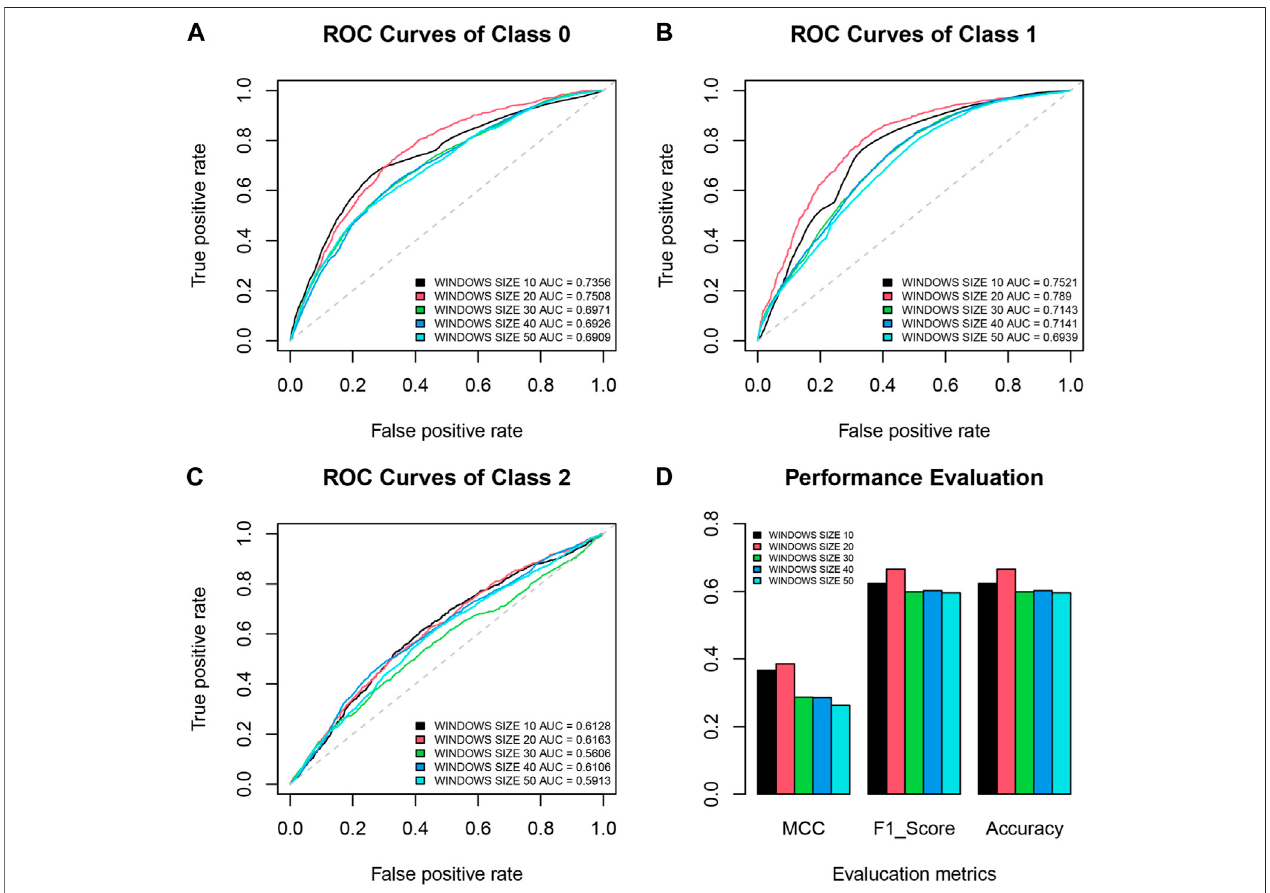
FIGURE 4 | Receiver operating characteristic (ROC) curves comparing model performance with window sizes of 10, 20, 30, 40, and 50 for (A) class 0, (B) class 1 and (C) class 2. (D) Bar plot curves of Matthews correlation coef fi cient (MCC), F1 score, and accuracy with window sizes of 10, 20, 30, 40, and 50.